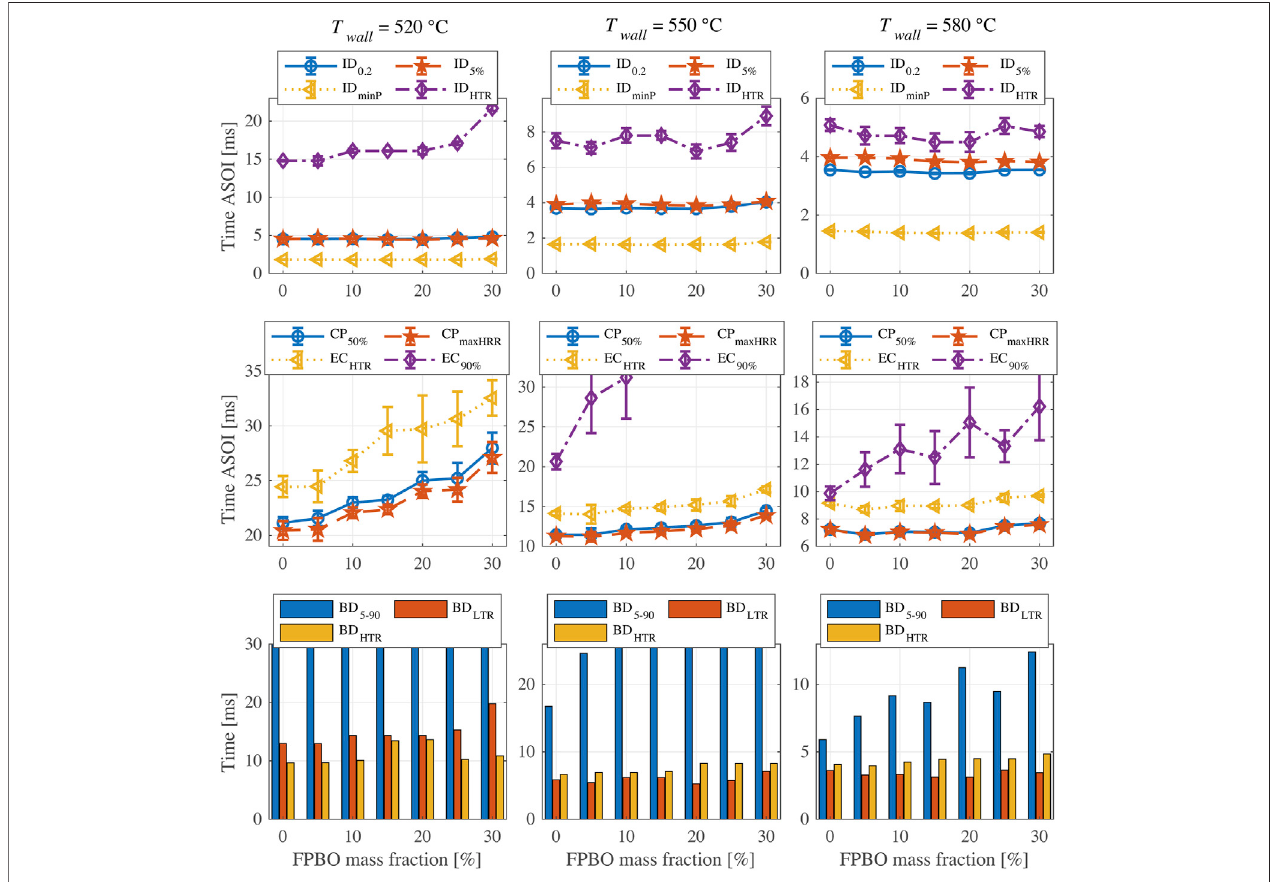
FIGURE 10 | Results of ignition and combustion indicators for FPBO and n-butanol blends (5% EHN) at different chamber wall temperatures.